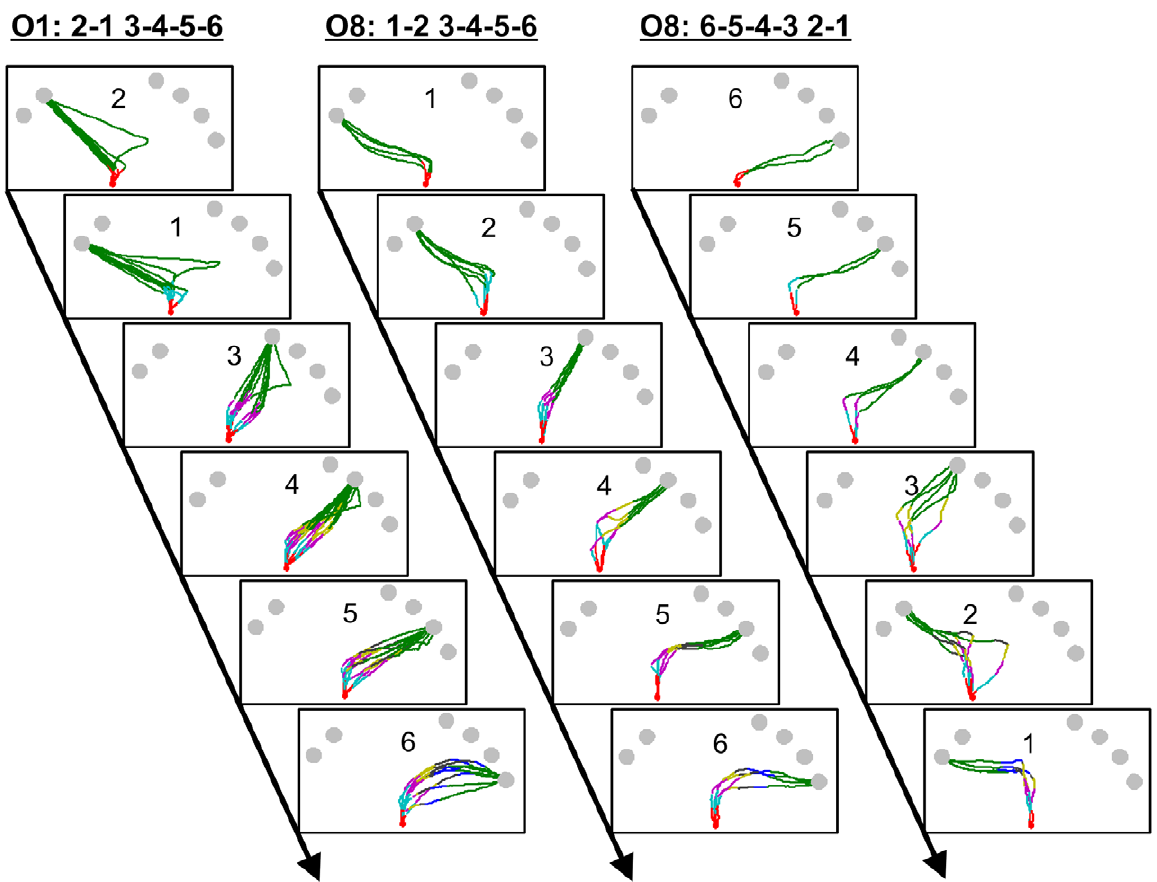
Figure 4. Eye-hand dynamics in the search-reach task. Hand trajectories in the search-reach task are plotted for two typical observers, O1 (left sequence) and O8 (middle and right sequences). Each sequence is for one specific search order (labeled at top). Each panel is for one specific target position (labeled in the panel). Each trajectory is for one trial. Colors along the trajectories code stages of visual search. Red denotes that no objects have been examined. Cyan denotes that 1 object has been examined, and so on. Green denotes that the target has been found. Note where the hand trajectories change going directions and how the trajectories vary with search order.